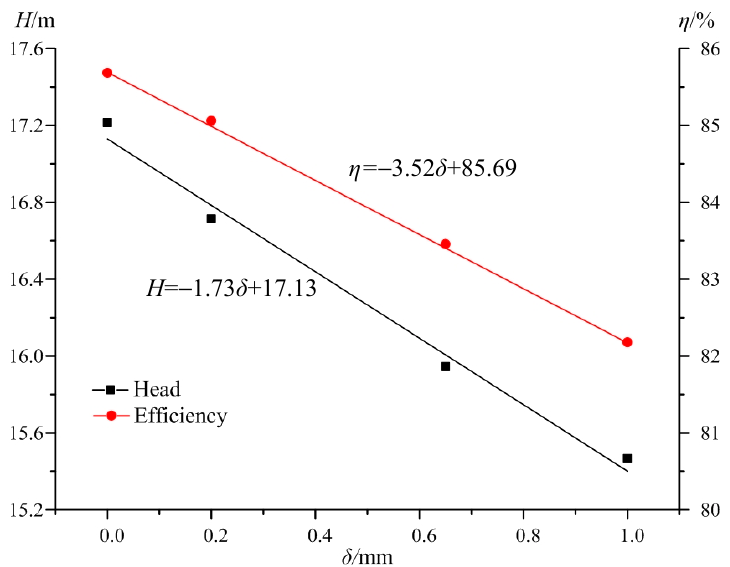
Figure 7. Pump head and efficiency with different tip clearance sizes at design flow rate.